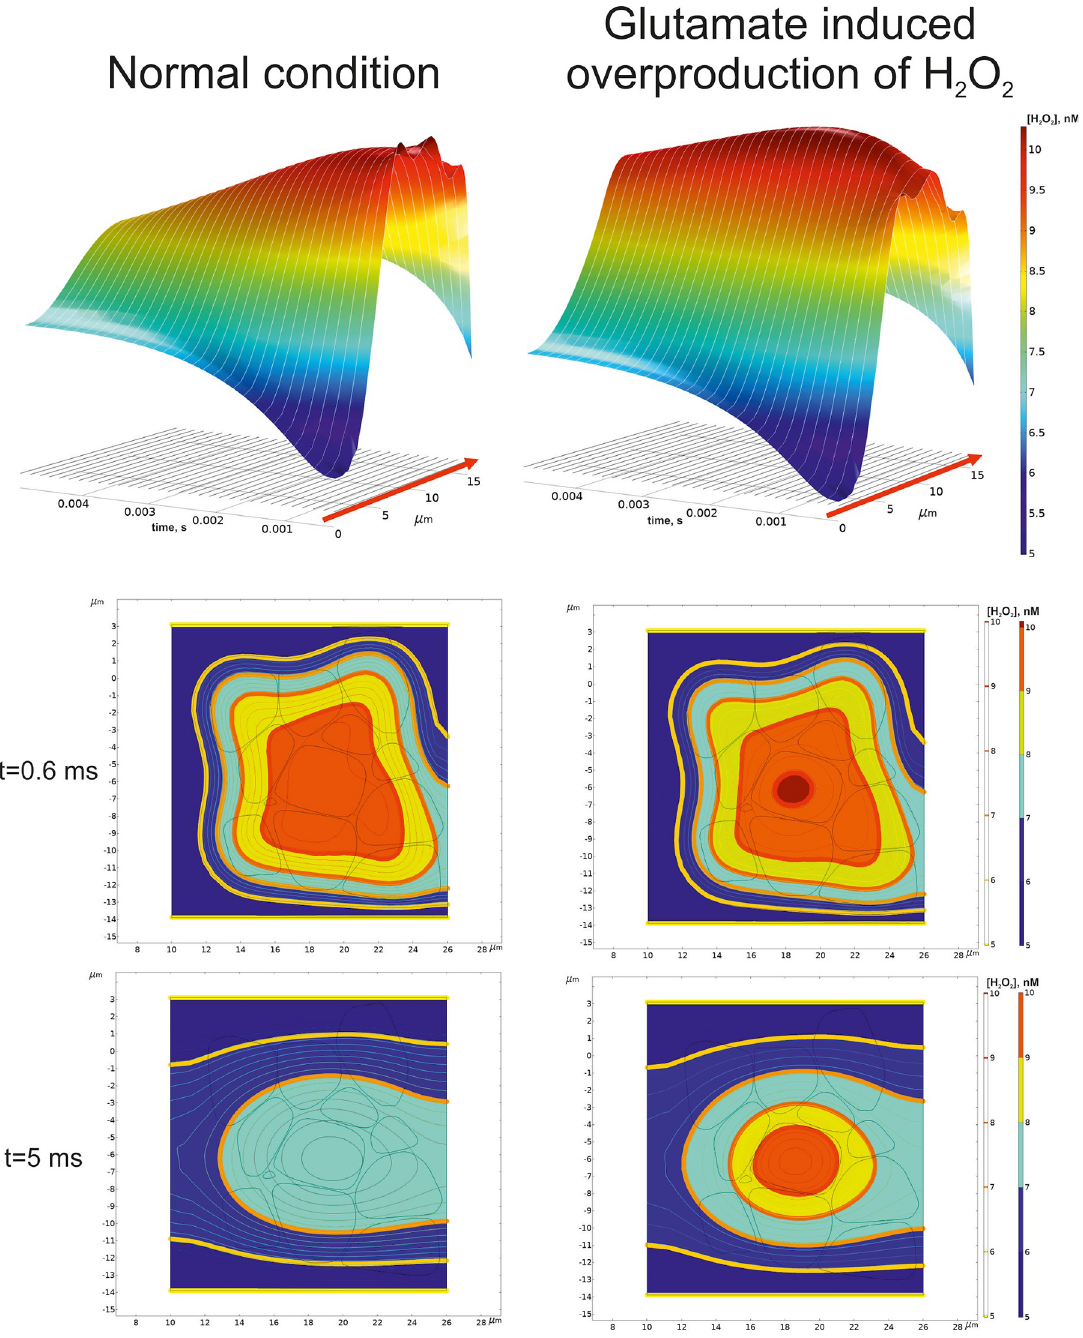
Fig 10. Spatial-time dependence of hydrogen peroxide concentration alone the central axis of the phantom. A 3D surface dependence of H 2 O 2 concentration on time and coordinate is represented in the top for a normal condition (left) and a glutamate- induced overproduction(right). The red arrow indicates the direction of the center axis shown in Fig 8. The central XY plane with iso- lines of H 2 O 2 concentrations and corresponding filled areas is shown below. The corresponding time moments are indicated in the left column.